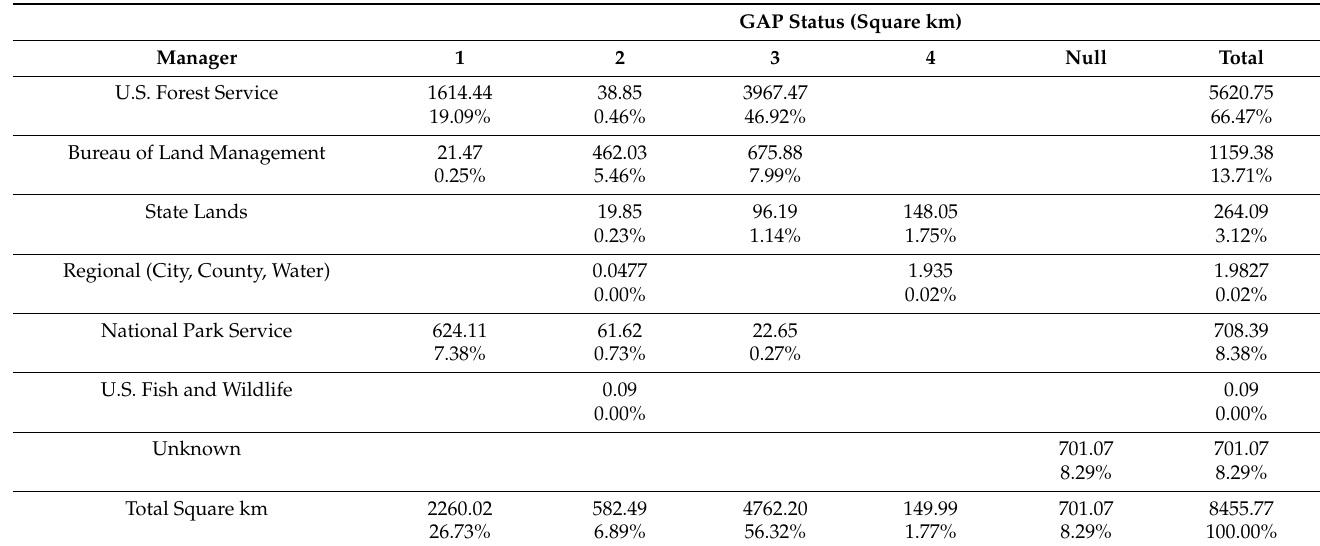
Table 5. GAP status and land managers of the Continental Divide Trail corridor. GAP Status (Square